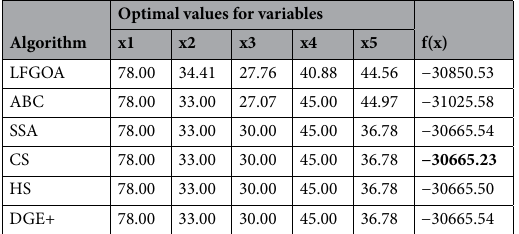
Table 15. Reported results for constrained problems from different optimizers. The best of the comparison results are in [bold].